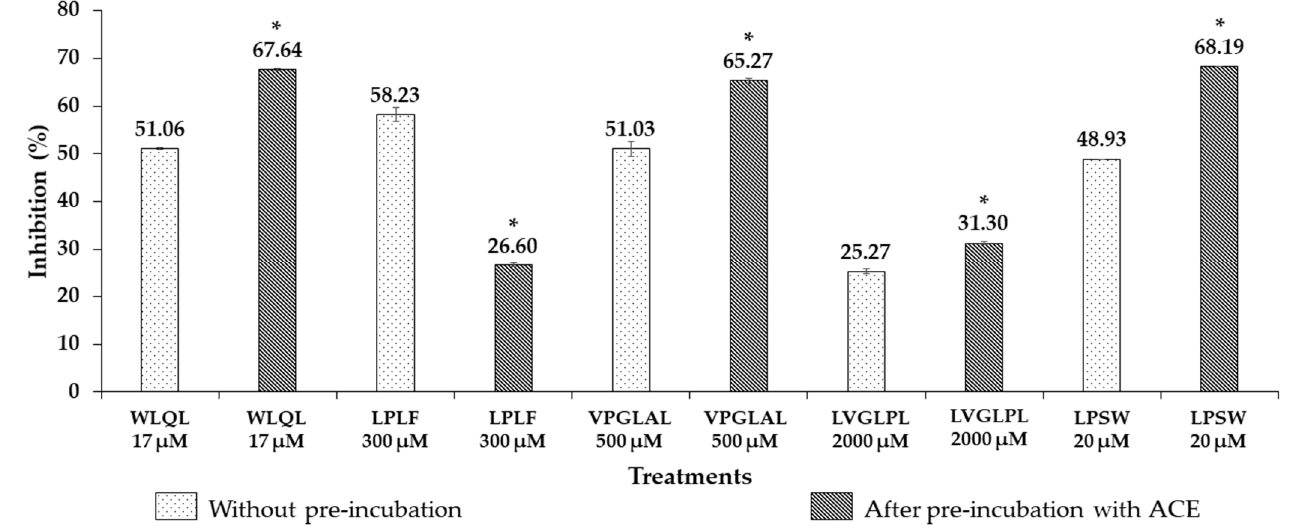
Figure A2. The ACE inhibitory activity of peptides with pre ‐ incubation assay. The error bars present the standard deviation (* indicated as significant difference between groups without and after pre ‐ incubation with ACE when p < 0.05). The concentrations utilized for comparison are dependent on each peptide.